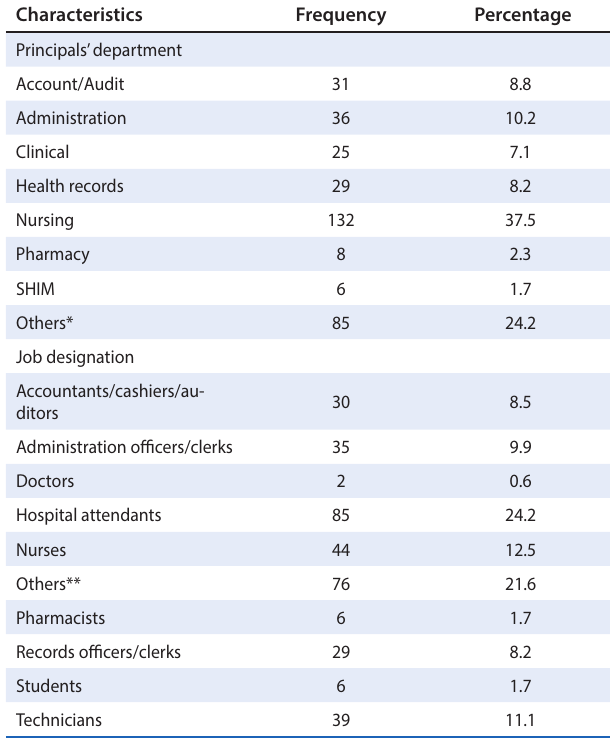
Table 2: Characteristics of the clinic